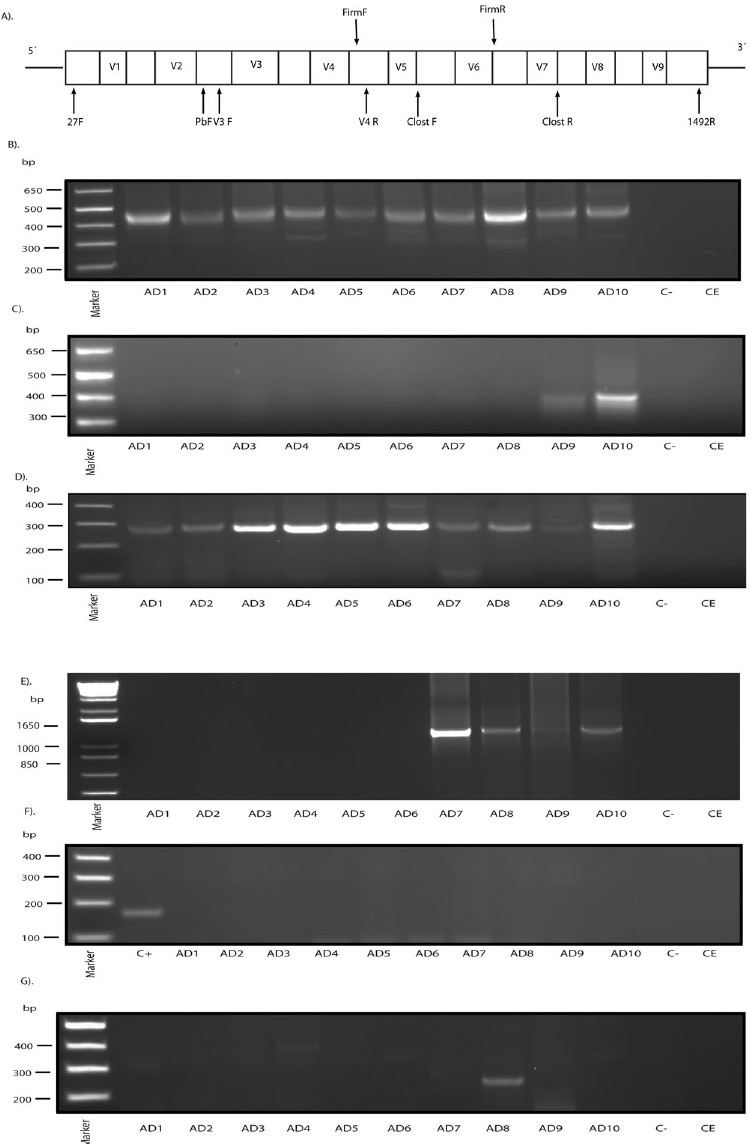
Figure 6. PCR analysis of different microorganisms in brain tissue from ten AD patients. Panel A: Schematic representation of bacterial 16 S rRNA gene with the different variable regions (V1–V9). Location of the primers employed for the different nested PCR carried out in this study: 27 F and 1492 R for the first PCR and the second PCR with the different sets of primers: V3F-V4R (universal primers), FirmF-FirmR ( Firmicute s primers), Clost F-Clost R ( Clostridium primers), P(b) F-1492R ( Bacillus primers). F: forward; R: reverse. Panels B–E: Agarose gel electrophoresis of the DNA fragments amplified by nested PCR of DNA obtained from frozen ERH tissue from ten AD patients. Panel B: Amplification of bacterial DNA fragment using universal oligonucleotide primers by nested PCR. The primers employed were 27F-1492R for the first round PCR and V3-V4 for the second PCR. All samples generated a product of 400 bp. Panel C: Amplification of Firmicutes DNA fragments using specific primers by nested PCR. The primers employed were 27F-1492R for the first PCR and Firm F-Firm R for the second PCR. AD9 and AD10 show a product of about 400 bp. Panel D: Identification of Clostridium spp. DNA by direct PCR. The primers employed were Clost F-Clost R. All the patients show a product of 300 bp. Panel E: Nested PCR assay to amplify Bacillus spp. The primers employed were 27F-1492R for the first PCR and P( b ) F-1492 R for the second PCR. AD7, AD8 and AD10 show a product of about 1100 bp. Panel F: Direct PCR analysis to amplify the gadB locus of E.coli . The primers employed were E.coli F and E.coli R. As positive control (C + ), DNA was extracted from E.coli . Panel G: Nested PCR analysis to amplify SAG2 partial gene of T. gondii. The primers used were Toxop FE and Toxop RE in the first PCR and Toxop FI and Toxop RI for the second PCR. AD8 amplified a product of about 260 bp. Control -: PCR without DNA. CE: Control of DNA extraction without brain DNA. DNA markers are indicated on the